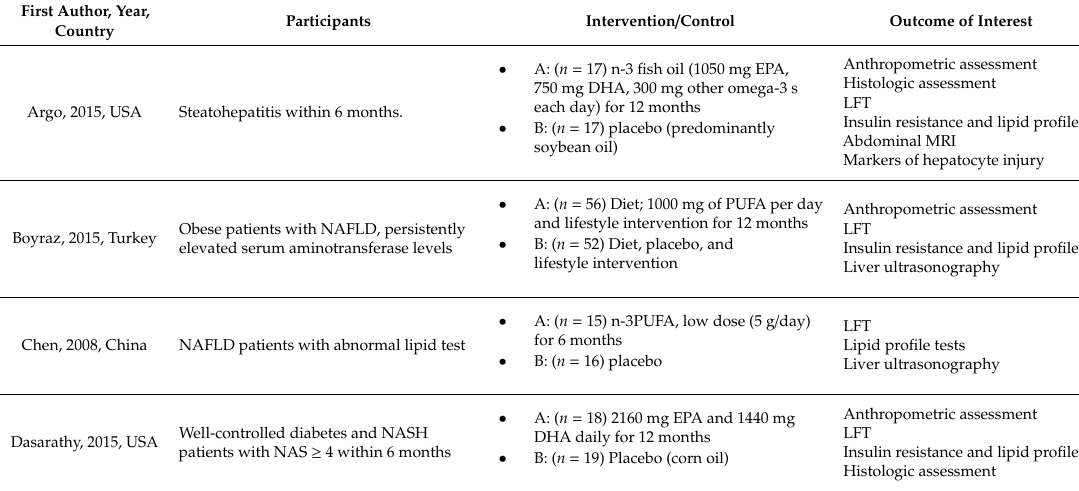
Table 2. Characteristics of included